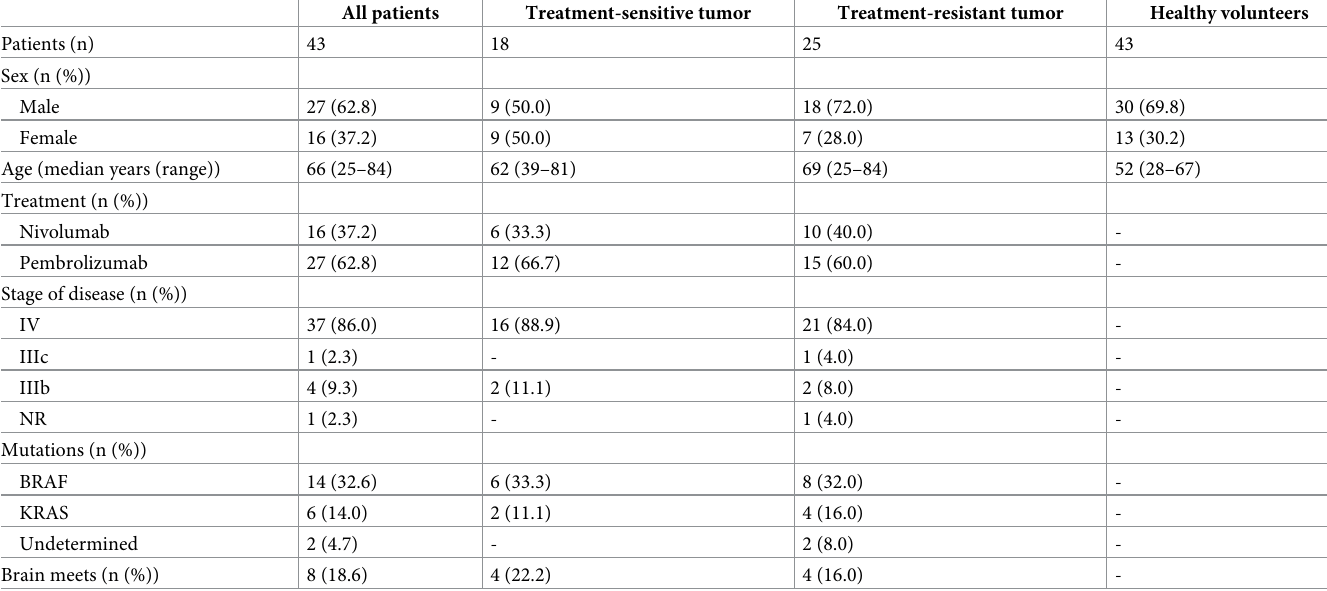
Table 1. Patient